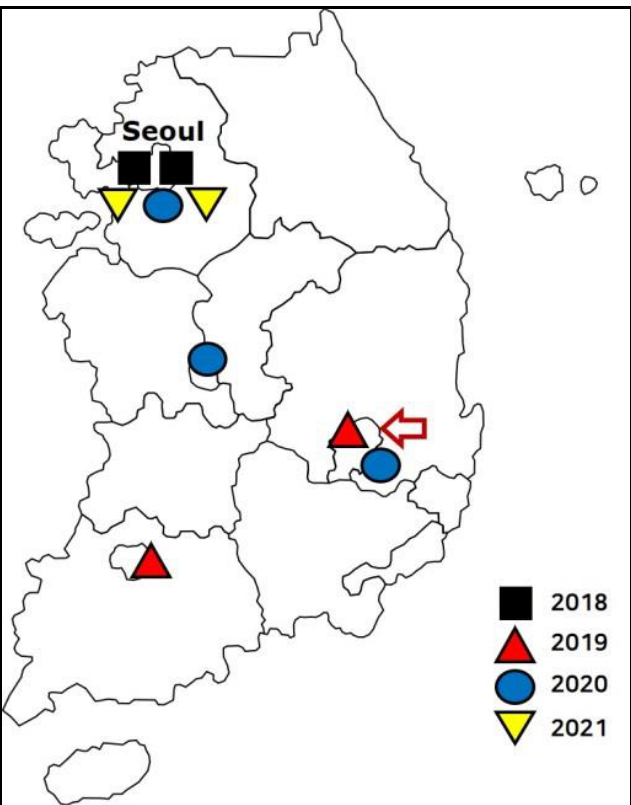
Figure 1. Pediatric palliative care centers in South Korea. Centers that opened in 2018 ( ), 2019 ( ), and 2021 ( ) are shown. The red arrow indicates the first local pediatric palliative care center.